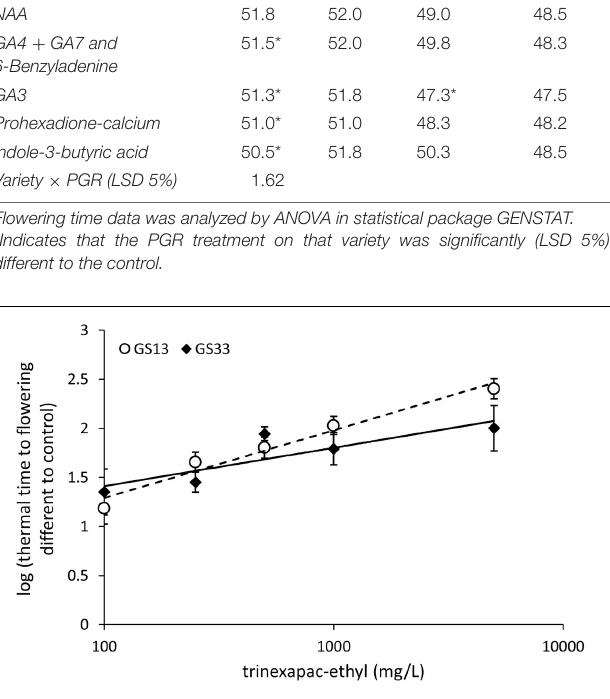
FIGURE 1 | The concentration response curve for trinexapac-ethyl with one spray application at three leaf stage (GS13) or GS33 with five different concentrations in Spartacus CL. Each fitted with a logarithmic trend line where error bars are representative of one standard error of the mean of four